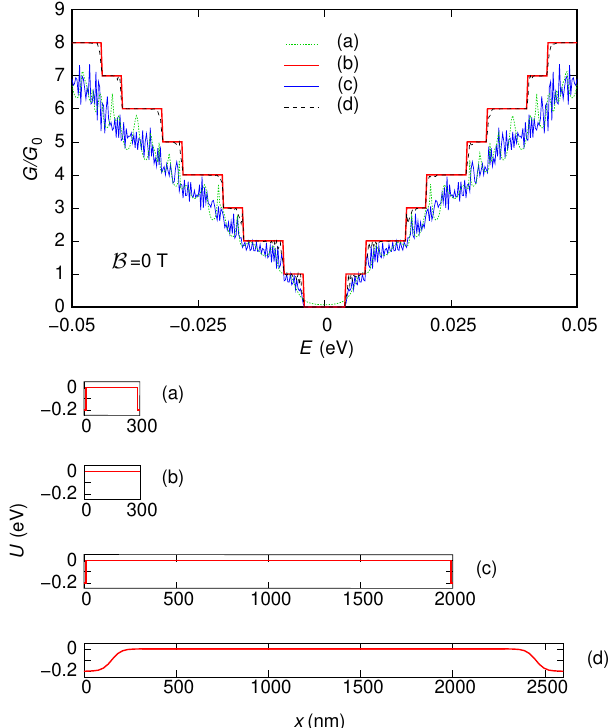
Figure 9. Conductance G , normalized with respect to the conductance quantum G 0 , which was obtained as a function of the Fermi energy E , in the absence of an orthogonal magnetic field B and with a zero potential in the region of interest in the following four conditions: ( a ) 150 nm-wide and 300 nm-long graphene ribbon with 5 nm-long abrupt contacts at the entrance and at the exit; ( b ) 150 nm-wide and 300 nm-long graphene ribbon without including the contacts; ( c ) 150 nm-wide and 2000 nm-long graphene ribbon with 5 nm-long abrupt contacts at the entrance and at the exit; ( d ) 150 nm-wide and 2000 nm-long graphene ribbon with 300 nm-long smooth contacts at the entrance and at the exit. The longitudinal sections of the corresponding potential profiles are sketched in the lower part of the figure.